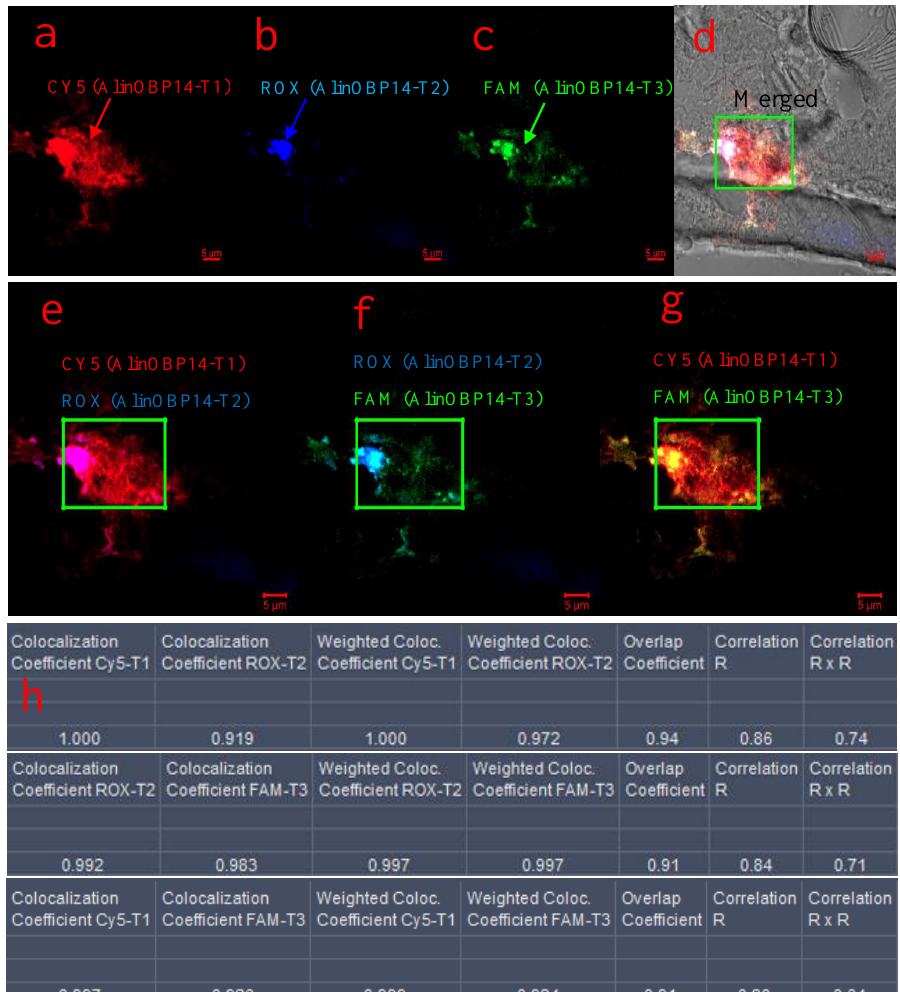
Figure 4. Colocalization analysis of the enhanced fluorescence signals beneath the epidermis of the gena in the head of adult A. lineolatus. ( a ) Excitation at 643 nm corresponding to CY5-P1 (red arrow). ( b ) Excitation at 575 nm corresponding to ROX-P2 (blue arrow). ( c ) Excitation at 488 nm corresponding to FAM-P3 (green arrow). ( d ) Merged image of three different fluorescence channels under a bright-field background. The green box indicates fluorescence signals that were intensified beneath the epidermis of the gena. After background correction, images were processed for colocalization analysis. ( e ) The spatial overlap of CY5-P1 and ROX-P2 fluorescence channels in a multichannel image. The green box indicates the area with colocalization of CY5-P1 with ROX-P2. ( f ) The spatial overlap of ROX-P2 and FAM-P3 fluorescence channels in a multichannel image. The green box indicates the area with colocalization of ROX-P2 with FAM-P3. ( g ) The spatial overlap of CY5-P1 and FAM-P3 fluorescence channels in a multichannel image. The green box indicates the area with colocalization of CY5-P1 with FAM-P3. ( h ) The values of coefficients calculated on images for CY5-P1 and ROX-P2, ROX-P2 and FAM-P3, and CY5-P1 and FAM-P3. The scale bar indicates 5 µm ( a – g ).